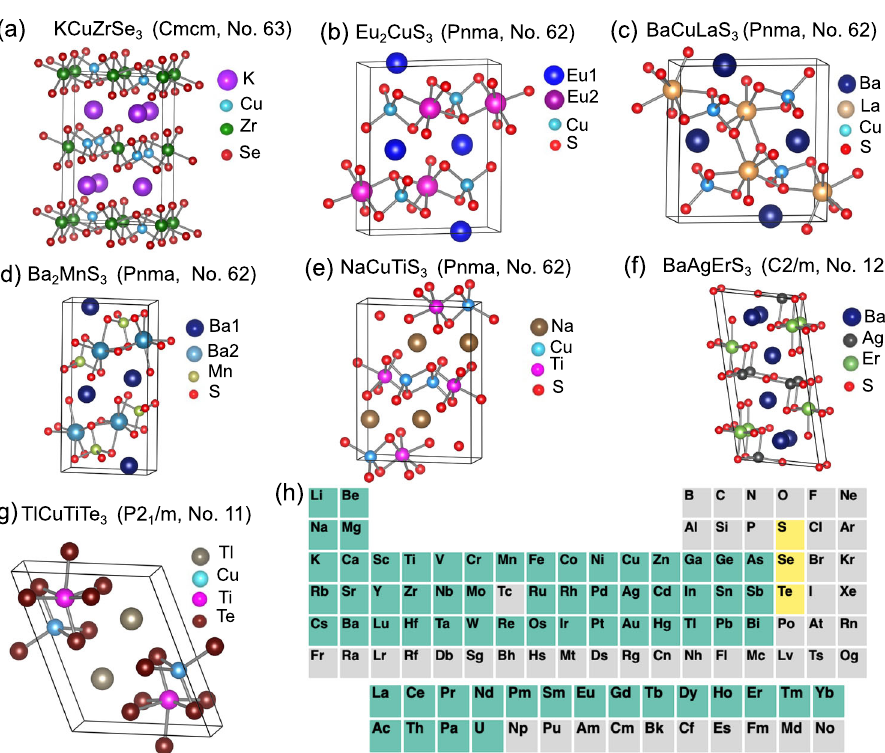
Fig. 2 Structural prototypes and elements used for novel material design. a – g Conventional unit cells of the seven crystallographic prototypes that are experimentally known in the family of AMM ′ Q 3 chalcogenides are shown. We have used these crystal structures for the design and discovery of new materials. h We have color-coded the 66 metallic elements (highlighted in green) in a periodic table that are substituted at the A, M-, and M ′ -cation sites in all possible combinations to generate the initial crystal structures of the new compounds. During prototype decoration, only three chalcogen atoms (highlighted in yellow) are substituted at the